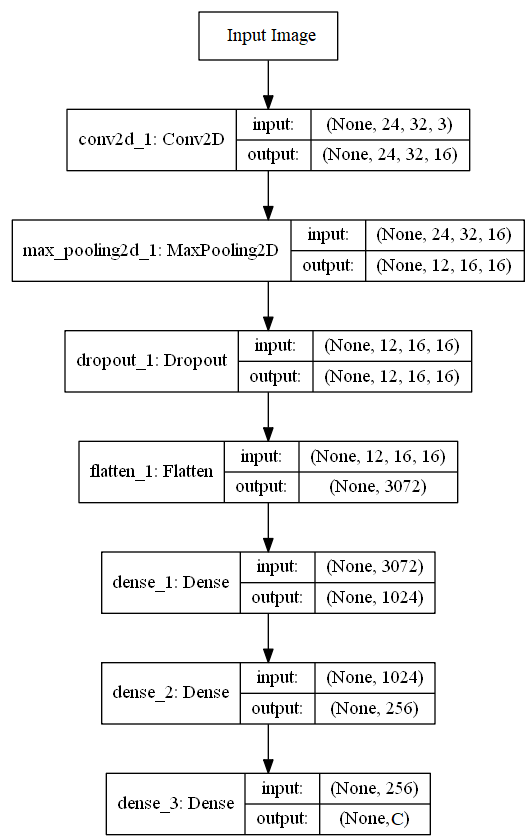
Figure 3. The proposed architecture of the convolutional neural network. The last layer output size, C, dynamically increases with the addition of new image classes.